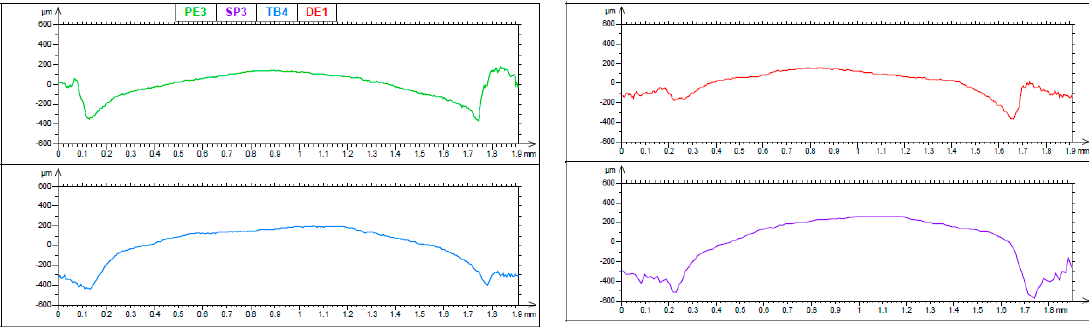
Figure 4. Cross sections of worn discs: upper row PE and DE, lower row TB and SP.